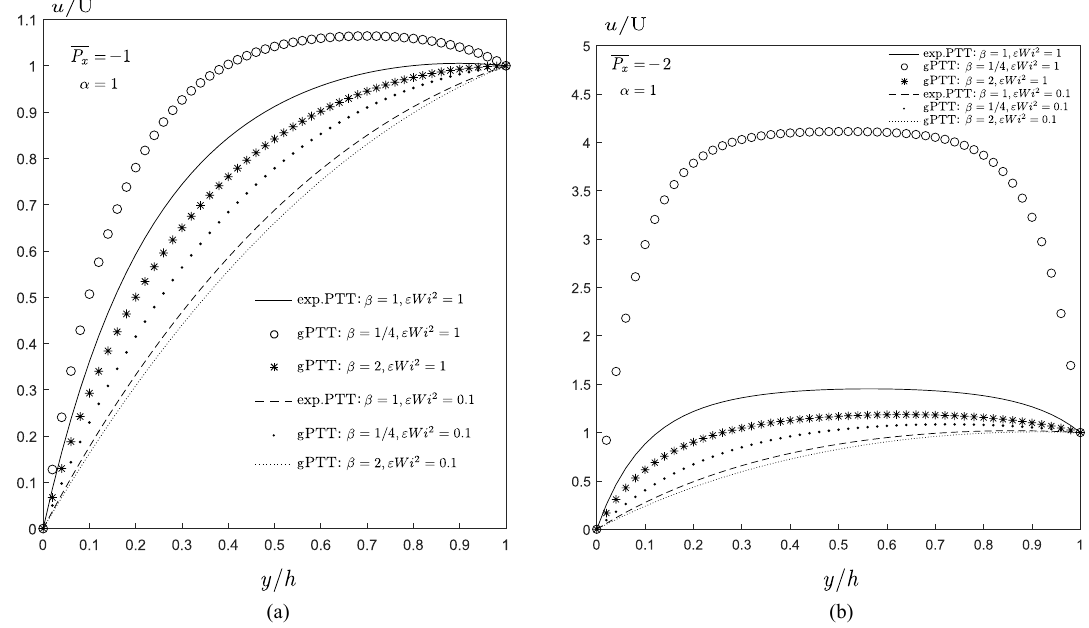
Figure 6. Velocity profiles obtained for the Poiseuille–Couette flow considering different values of ε Wi 2 and different values of β ( α = 1): ( a ) ¯ P x = − 1; and ( b ) ¯ P x = −